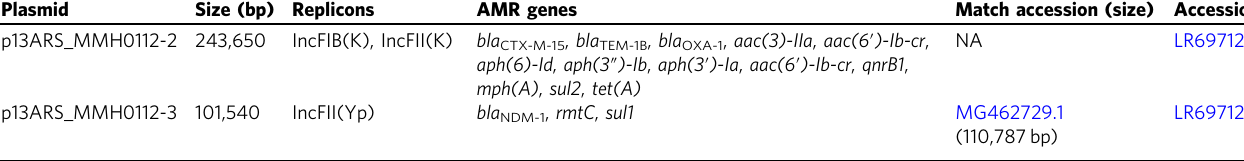
Table 2 Plasmids from K. pneumoniae ST340 strain 13ARS_MMH0112.